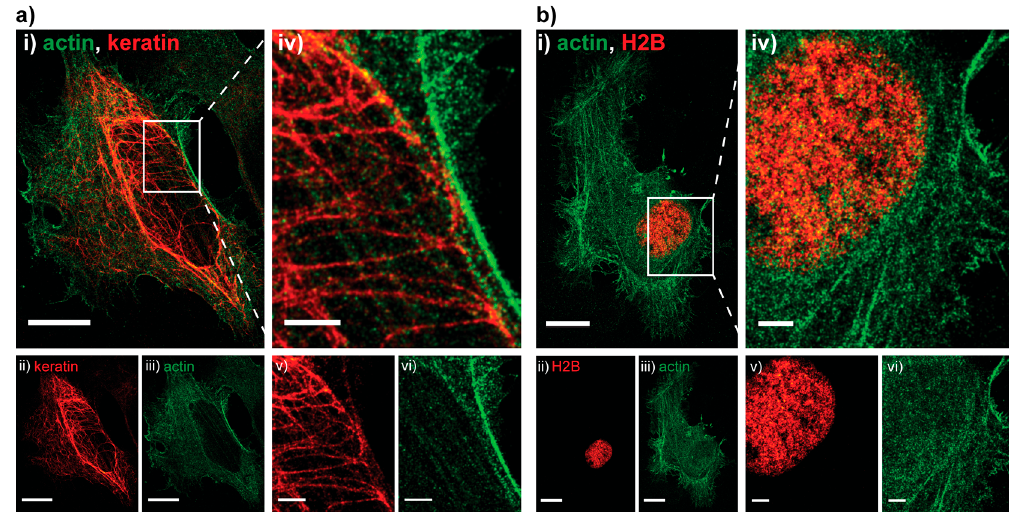
Figure 2. Two examples of Hela cells imaged with sequential PC activation. ( a ): ( i ) Dual-color PALM image of actin tagged with PamCherry (green) and keratin tagged with Dendra2 (red); ( ii , iii ) split channel PALM images of the same cell. Localization precision of the channels after drift correction (whole ROI, NeNA values): Dendra2 (red, keratin) 17.2 nm, PamCherry (green, actin) 17.4 nm, scale bars 5 μ m; ( iv – vi ) zoom in on an area with details only visible in the super resolved image, scale bars 2 μ m; ( b ): ( i ) Dual-color PALM image of actin tagged with PAmCherry (green) and H2B tagged with Dendra2 (red) and split channel images of the same cell ( ii , iii ). Localization precision of the channels after drift correction (whole ROI, NeNA values): Dendra2 (red, H2B) 16.1 nm, PamCherry (green, actin) 18.9 nm, scale bars 5 μ m; ( iv – vi ) zoom in on the nucleus, showcasing the absence of bleed through (dark background on ( vi )), scale bars 2 μ m.